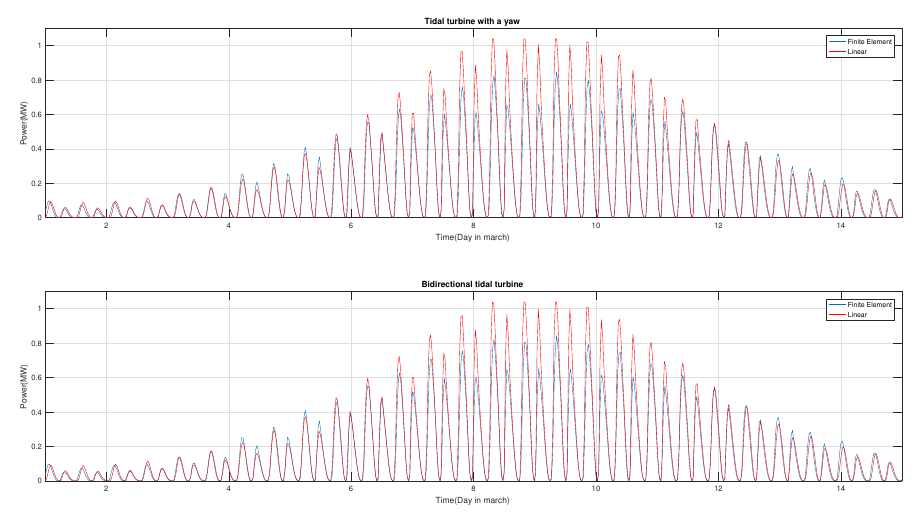
Figure 11. Time series of the predicted power production for yawed and fixed-axis turbines at point #2.